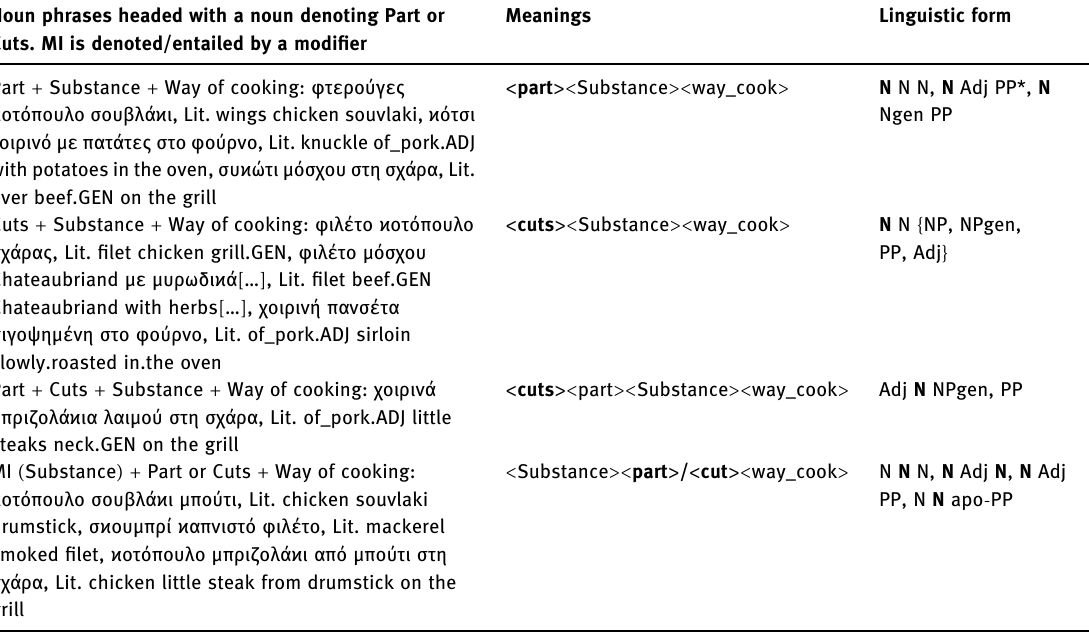
Table 6: The dish name denoting NP is headed by a noun denoting cuts or parts of the Source; the MI is entailed from or denoted by the modi fi ers of the head noun Noun phrases headed with a noun denoting Part or Meanings Linguistic Cuts. MI is denoted/entailed by a modi fi er